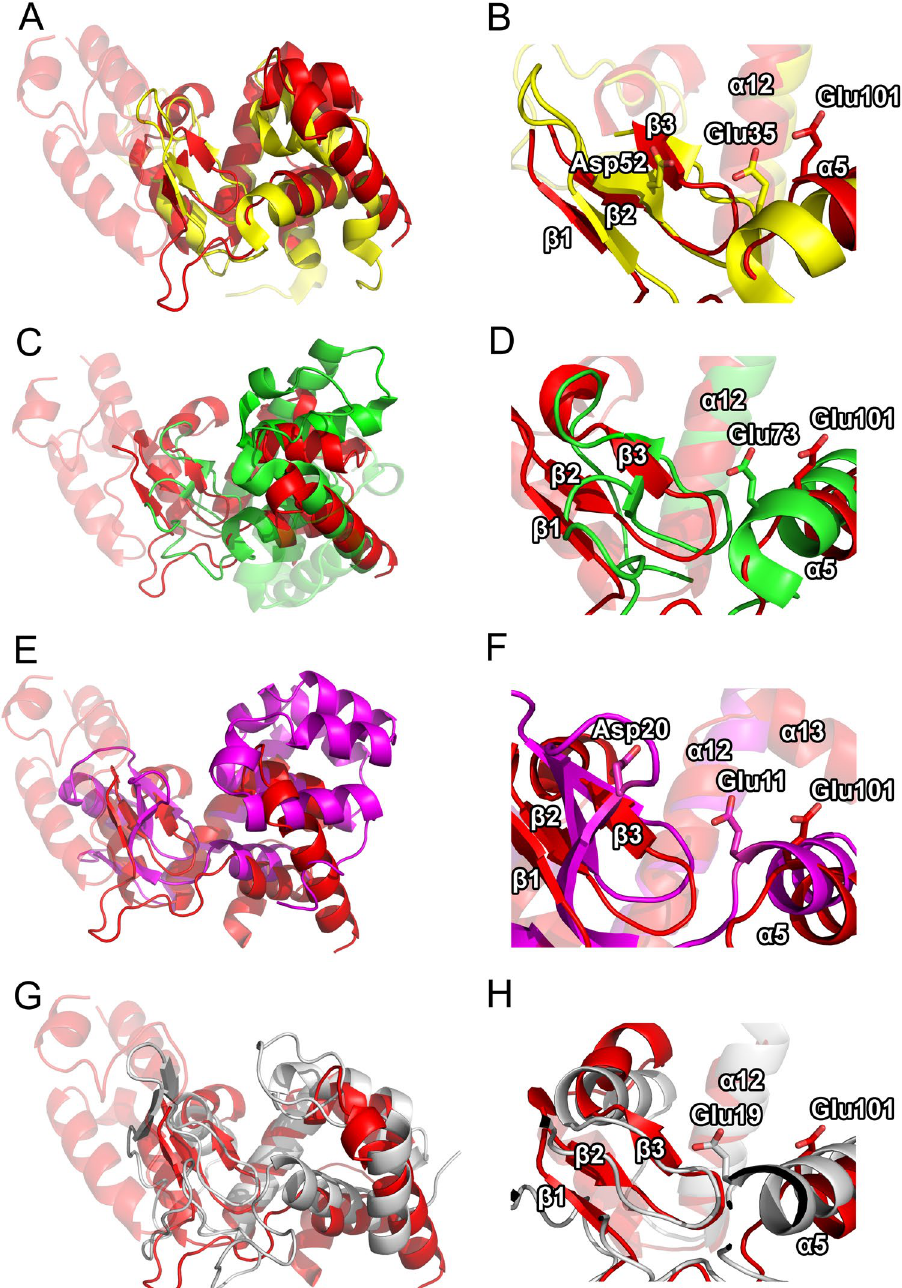
Figure 3. Structural alignment of AP3gp15 DUF3380 domain (red) and: ( A ) HEWL (yellow); ( C ) GEWL (green); ( E ) T4 lysozyme (purple) and ( G ) phage lambda lytic transglycosylase (silver). Structural alignment of the catalytic center of the AP3 endolysin DUF3380 domain (red) and: ( B ) HEWL (yellow); ( D ) GEWL (green); ( F ) T4 lysozyme (purple) and ( H ) phage lambda lytic transglycosylase